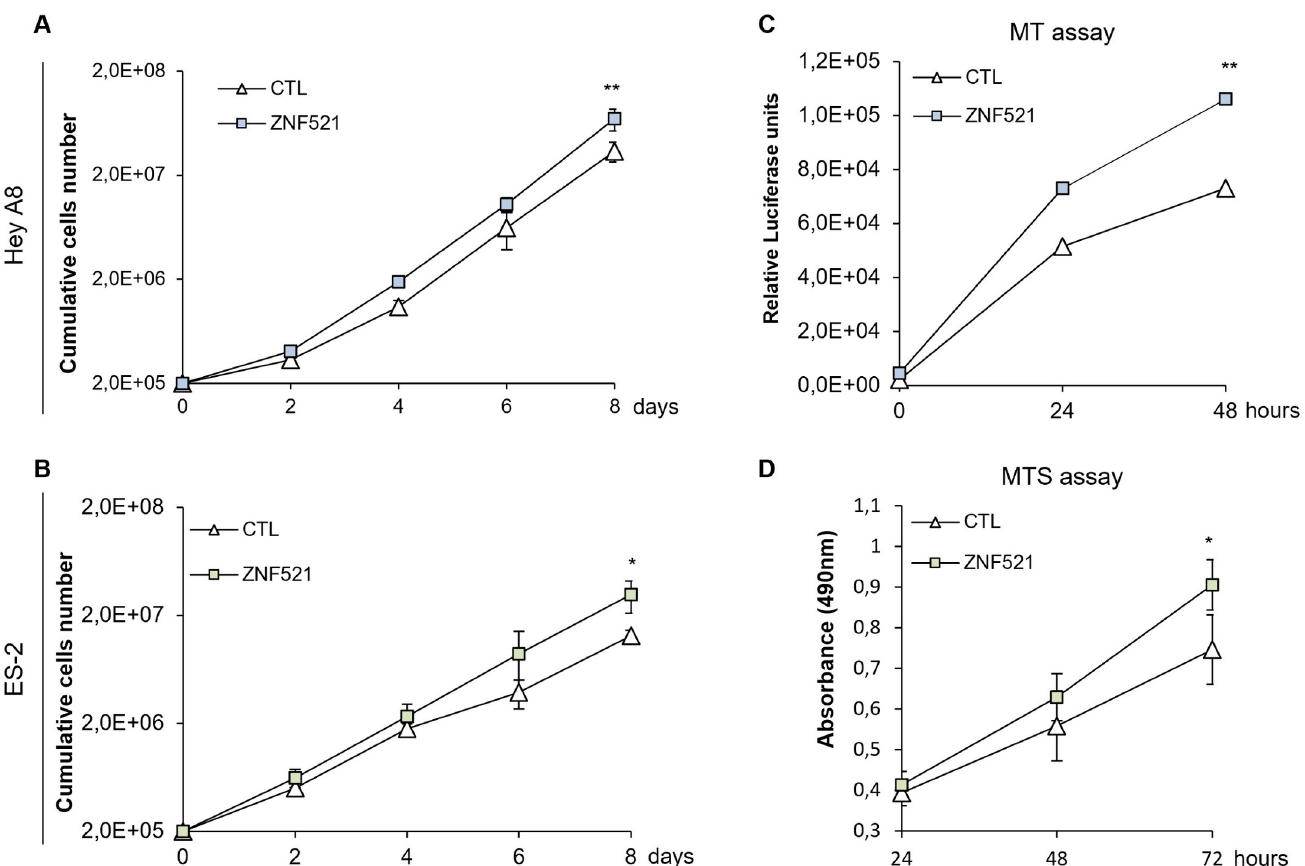
Fig 2. Forced ZNF521 expression confers an advantage in proliferation of OC cells. The growth of HeyA8 (A and C) and ES-2 (B and D) transduced cells was assessed by cell counts (A and B) or by MT (C) and MTS assays (D). Data shown the mean of 3 sets, each conducted in triplicate. Asterisks indicate p < 0,05 � , p < 0,01 �� , p < 0,001 ��� .